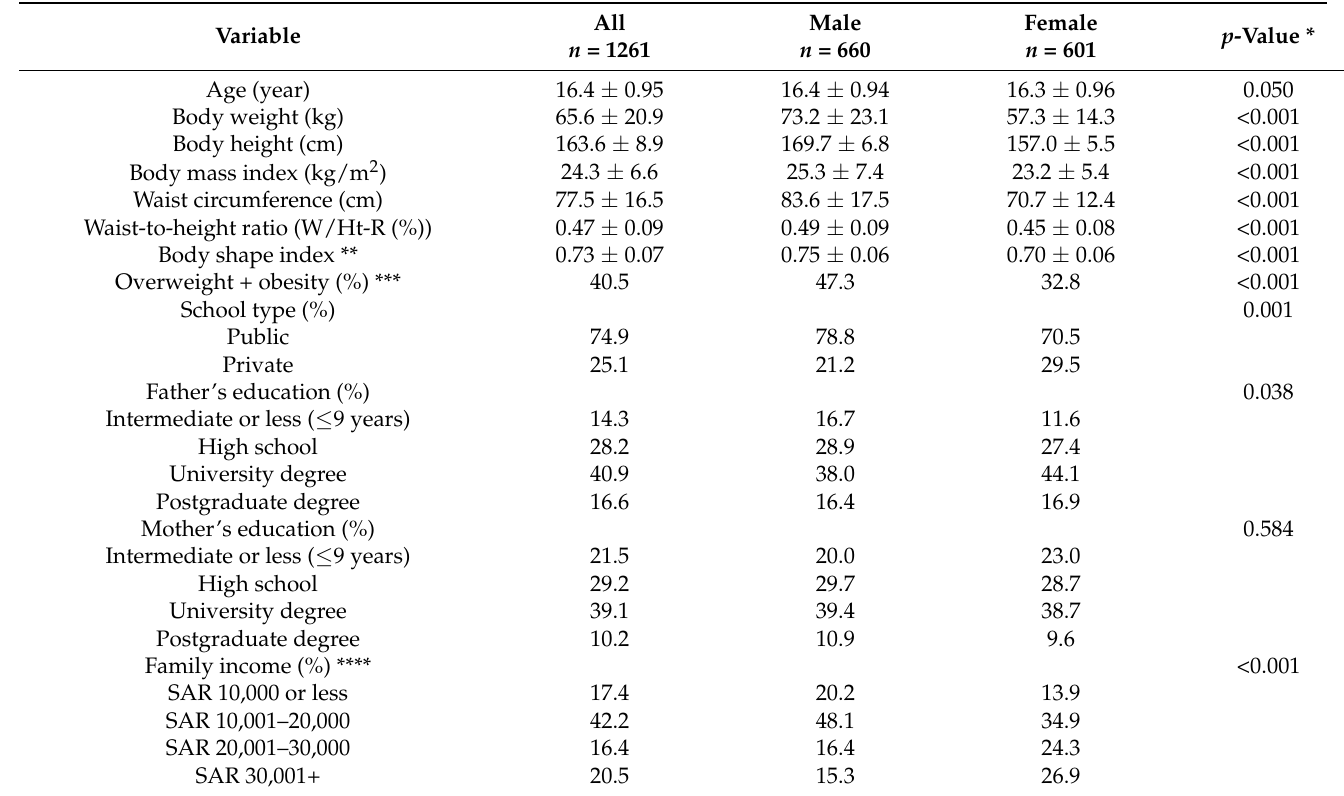
Table 1. Anthropometric characteristics of the participants relative to